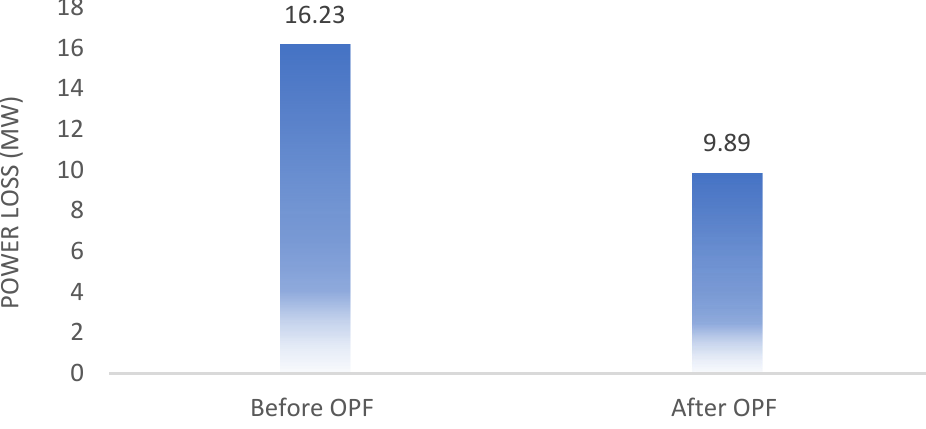
Figure 5. Comparing the Power losses before and after OPF.